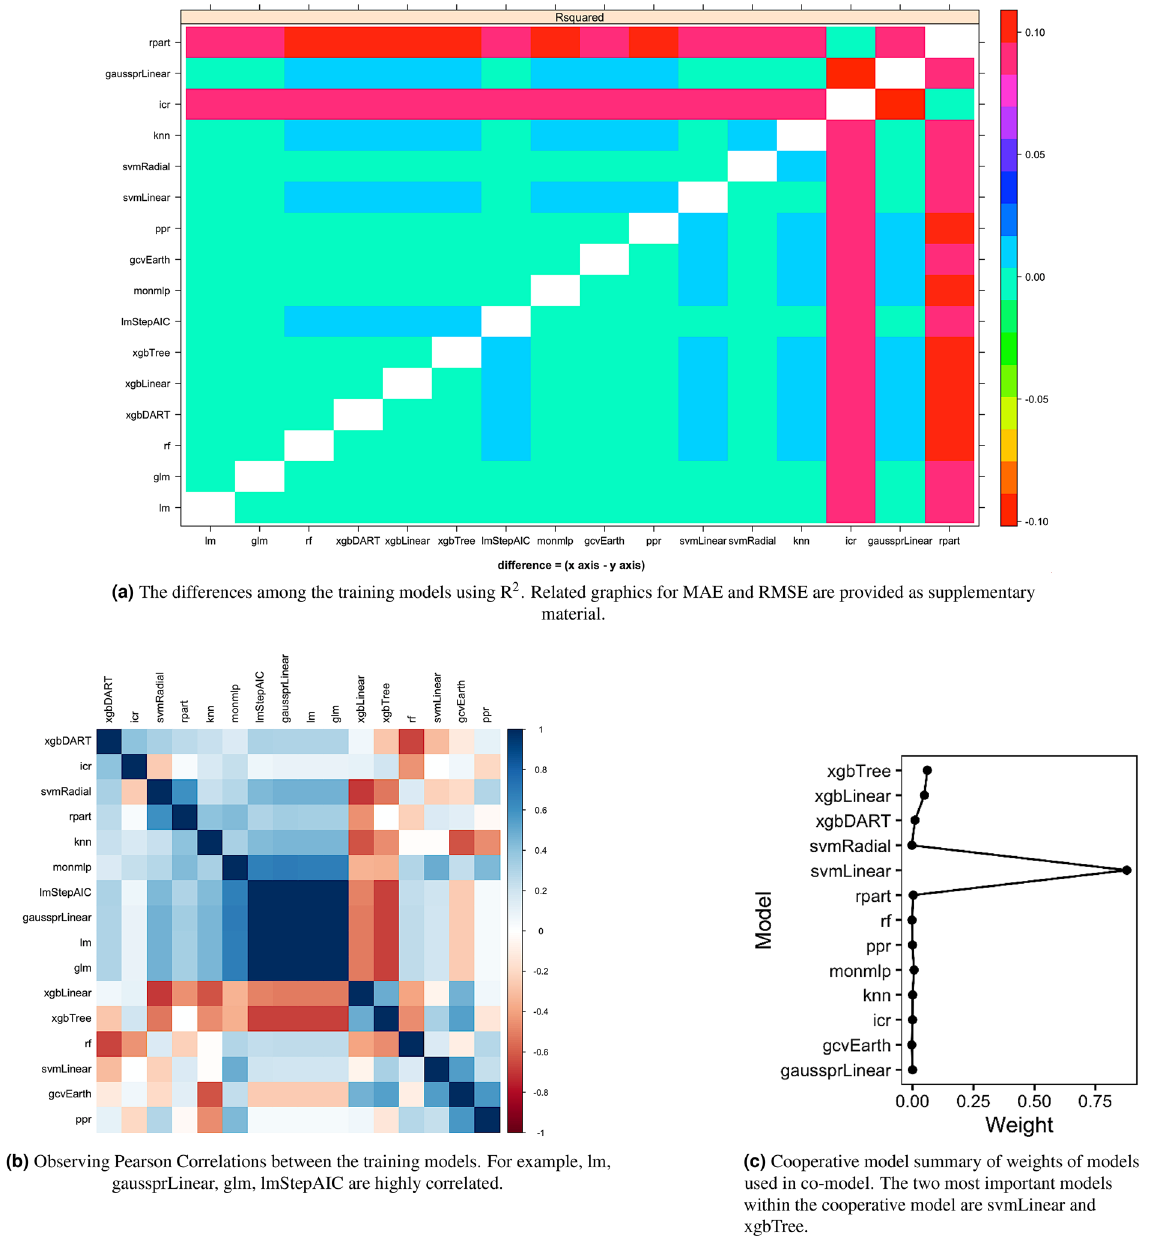
Figure 6. Determining the models for the cooperative model ( a , b ) and the details of the cooperative model ( c